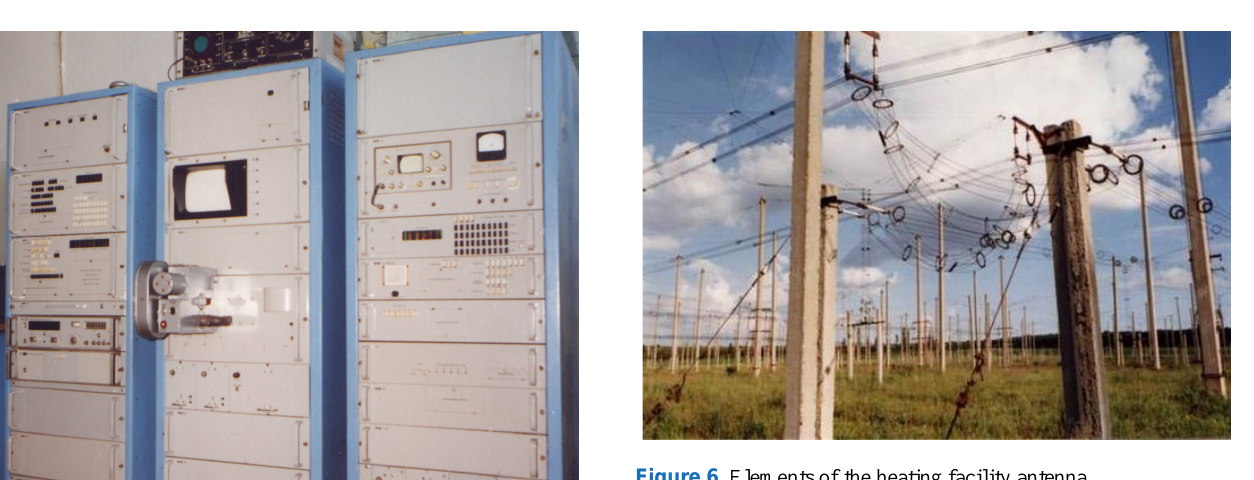
Figure 6. Elements of the heating facility